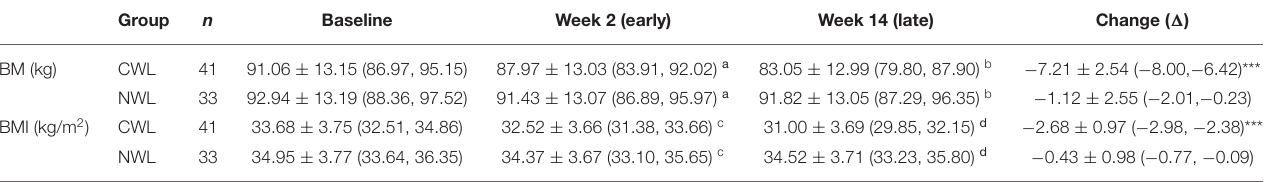
TABLE 3 | Change in body mass (BM) and body mass index (BMI) between baseline, week 2 and week 14. Group